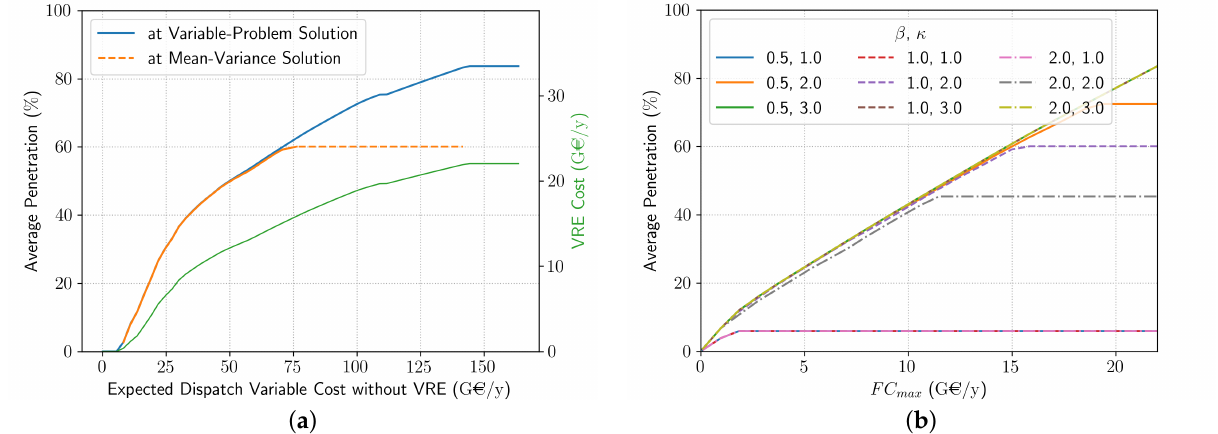
Figure 11. ( a ) Average penetration (Equation (26)) (left y -axis) versus the expected system total cost without Variable Renewable Energy (VRE) for numerical approximations of the optimal solutions to the variable problem (Equation (4)) (blue) and to the mean-variance problem (Equation (27)) with κ = 2 and β = 1 (orange). The latter is represented by a plain line when the VRE rental cost constraint is active (when its multiplier is positive) and by a dashed line when it is not. ( b ) Average penetration (left y -axis) versus the maximum VRE rental cost for numerical approximations of the optimal solutions to the the mean-variance problem (Equation (27)) for different values of κ and β (orange). For κ = 1 and 3, the curves for different values of β